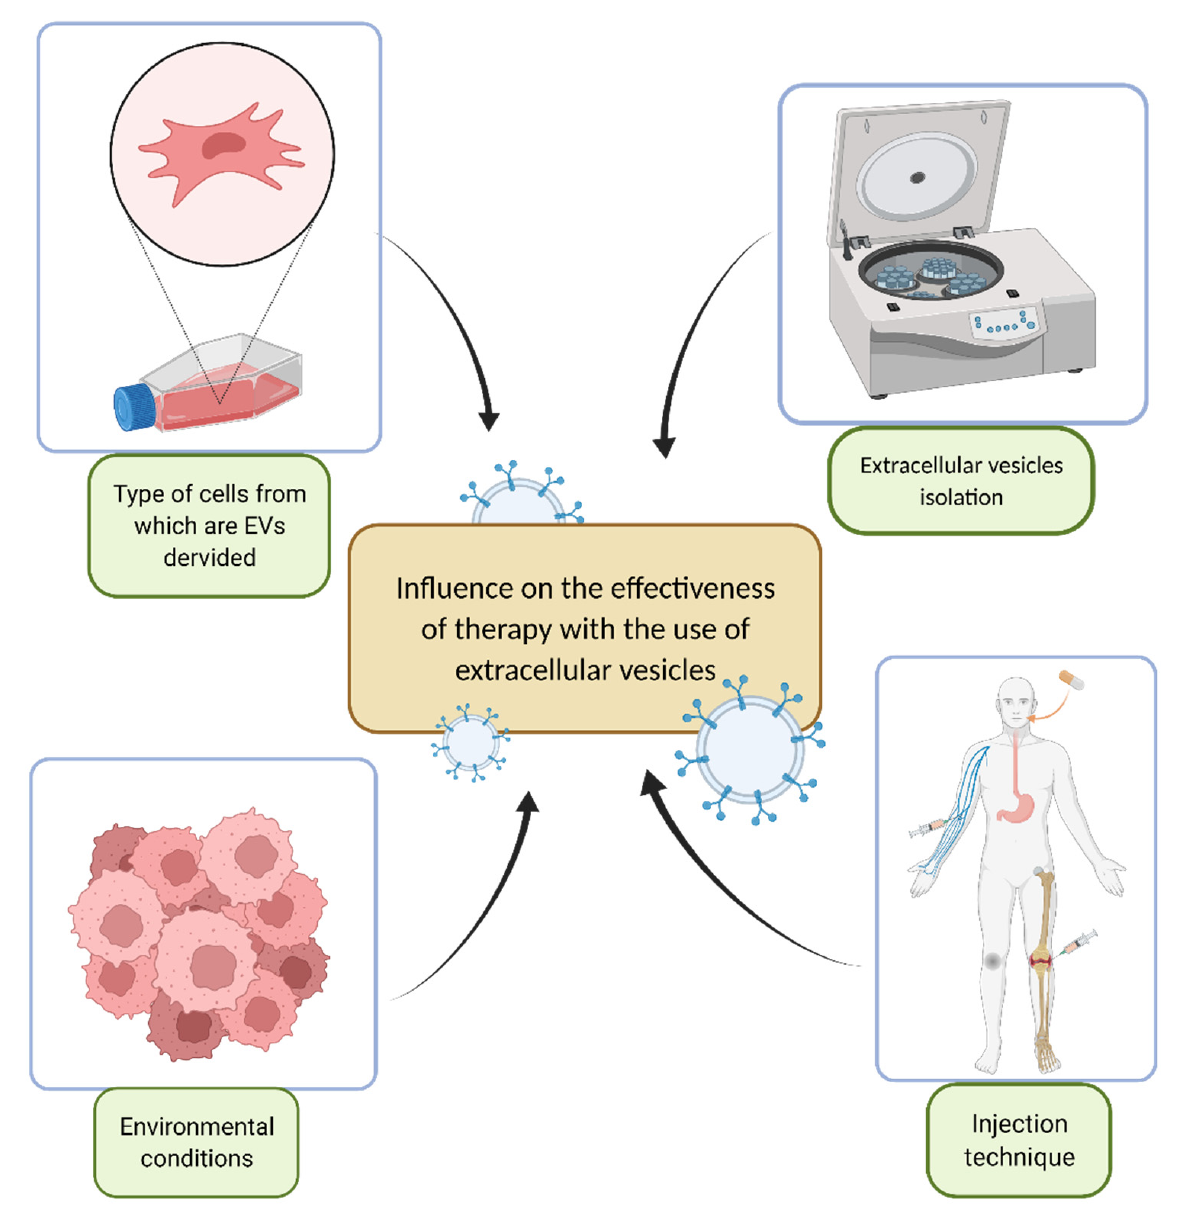
Figure 1. Factors that influence the effectiveness of treatment with extracellular vesicles. The origin of EVs affects their features, such as their immunity, toxicity, and therapeutic properties, as they bear the hallmark of the parental cells. Isolation procedures, such as centrifugation techniques, may cause changes in EV membrane structure that lead to the loss and gain of features that may be dangerous for the patient and cannot always be predicted at the design stage. There are differences in experimental conditions for vesicle release between cell culture studies, animal studies, and preclinical studies. The environmental conditions of EV release affect the quality and quantity of EVs; therefore, experimental therapies may have difficulty achieving the target amount of EVs. The injection technique of EV administration affects their pharmacokinetics and bio-distribution. Intravenous injection makes EVs more accessible to the immune system and prone to phagocytosis. The accumulation of EVs in the organs is higher after intravenous injection than after intramuscular or subcutaneous injection, which affects the therapeutic